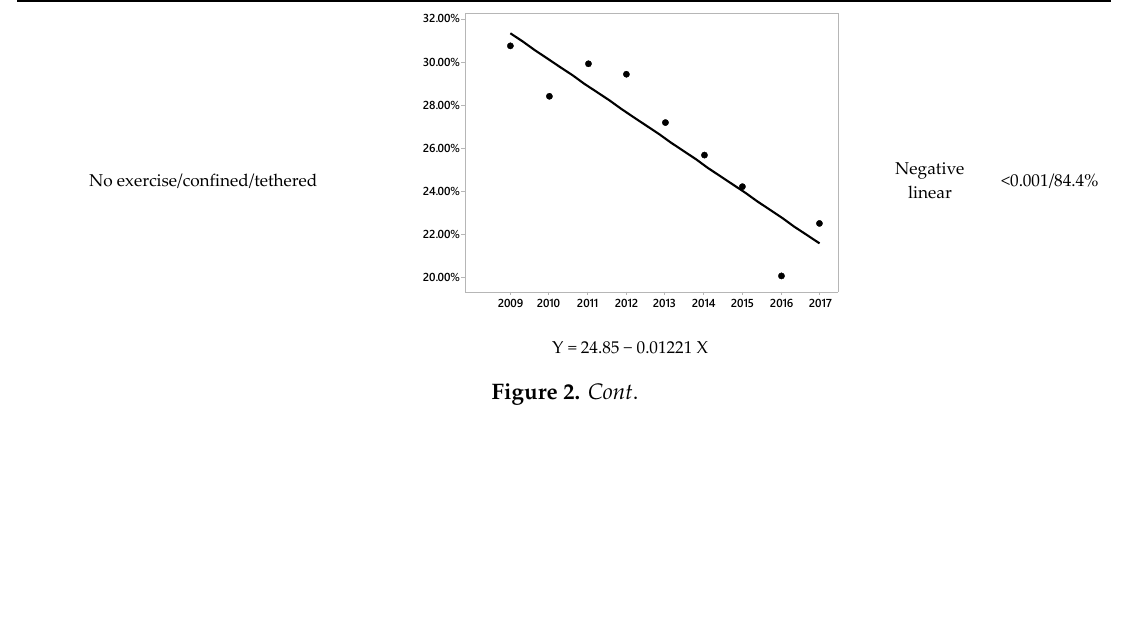
Figure Pattern p Value/R-Sq